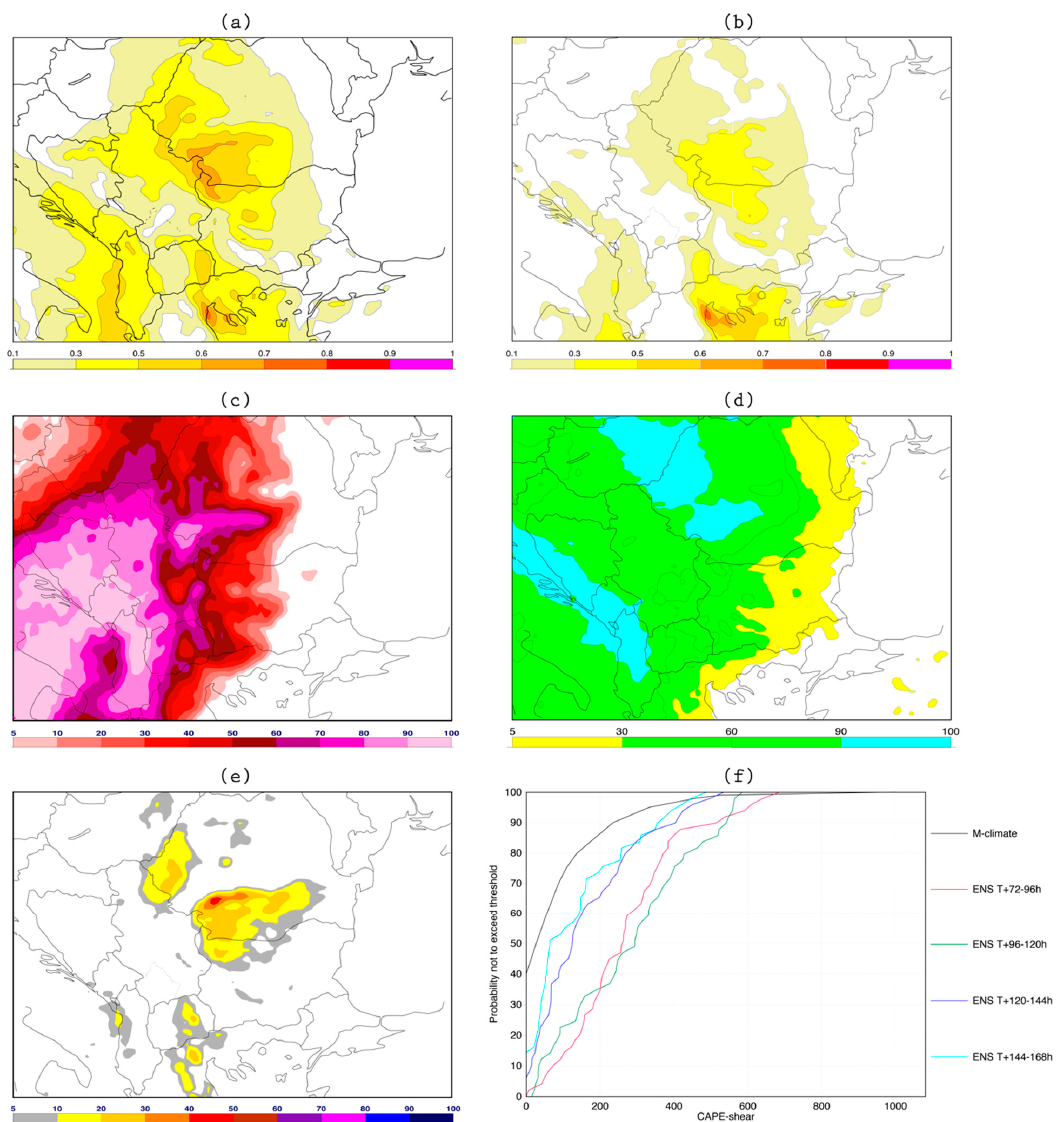
Figure 10. ECMWF medium-range forecast (T + 72–96 h) of ( a ) CAPE-shear Extreme Forecast Index (EFI), ( b ) CAPE EFI, ( c ) probability of the 925–500 hPa wind shear exceeding 20 m s − 1 , ( d ) probability of precipitation (PoP), ( e ) probability of lightning density above 0.5 flashes per 100 km − 2 h − 1 and ( f ) CAPE-shear (in units of m 2 s − 2 ) cumulative distribution functions (CDFs) for Pleven. The M-climate is shown in black, while the forecasts at different ranges are presented with various colors indicated in the legend.